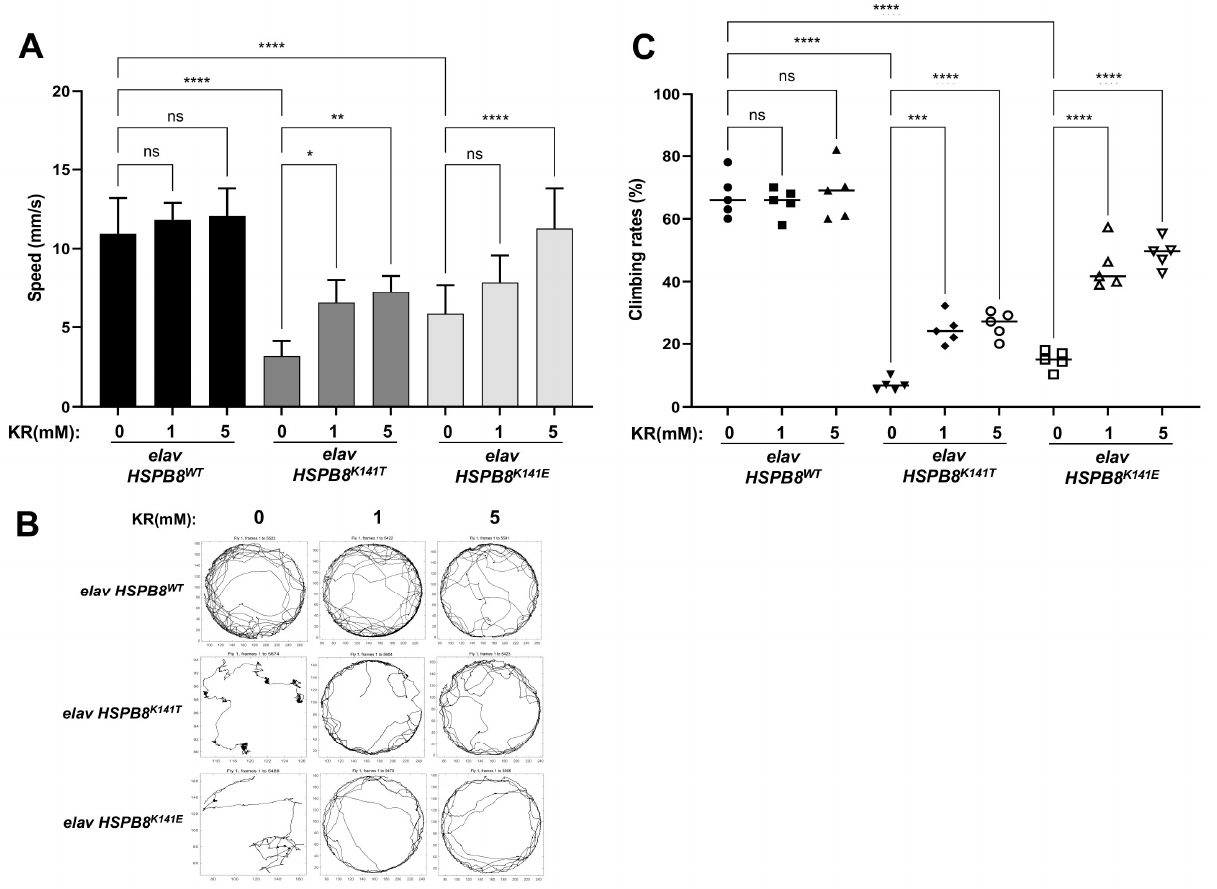
Figure 5. KR treatment ameliorated the loss of motor activity in mutant HSPB8 transgenic flies. ( A ) and ( B ) Comparison of the mean walking speeds ( A ) and movement trajectories ( B ) for 15 ‐ day ‐ old elav HSPB8 WT , elav HSPB8 K141T and elav HSPB8 K141E male flies treated with vehicle (0 mM) or KR (1 and 5 mM). ( C ) Comparison of the climbing ability of 15 ‐ day ‐ old male flies after KR treatment ( n = 5 per group). Significance was determined by Sidak test after one ‐ way ANOVA (*, p < 0.05; **, p < 0.01; ***, p < 0.001; ****, p < 0.0001; ns, not significant). Error bars indicate the mean ± SD.